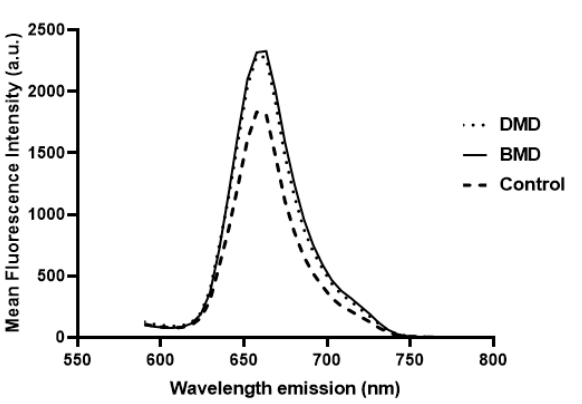
Figure 2. β -spectrin mean fluorescence intensity in relation to emission wavelength computed from β -spectrin spectral stacks of samples. DMD (dotted line) and BMD (solid line) showed higher fluorescence intensity than healthy subjects (dashed line).